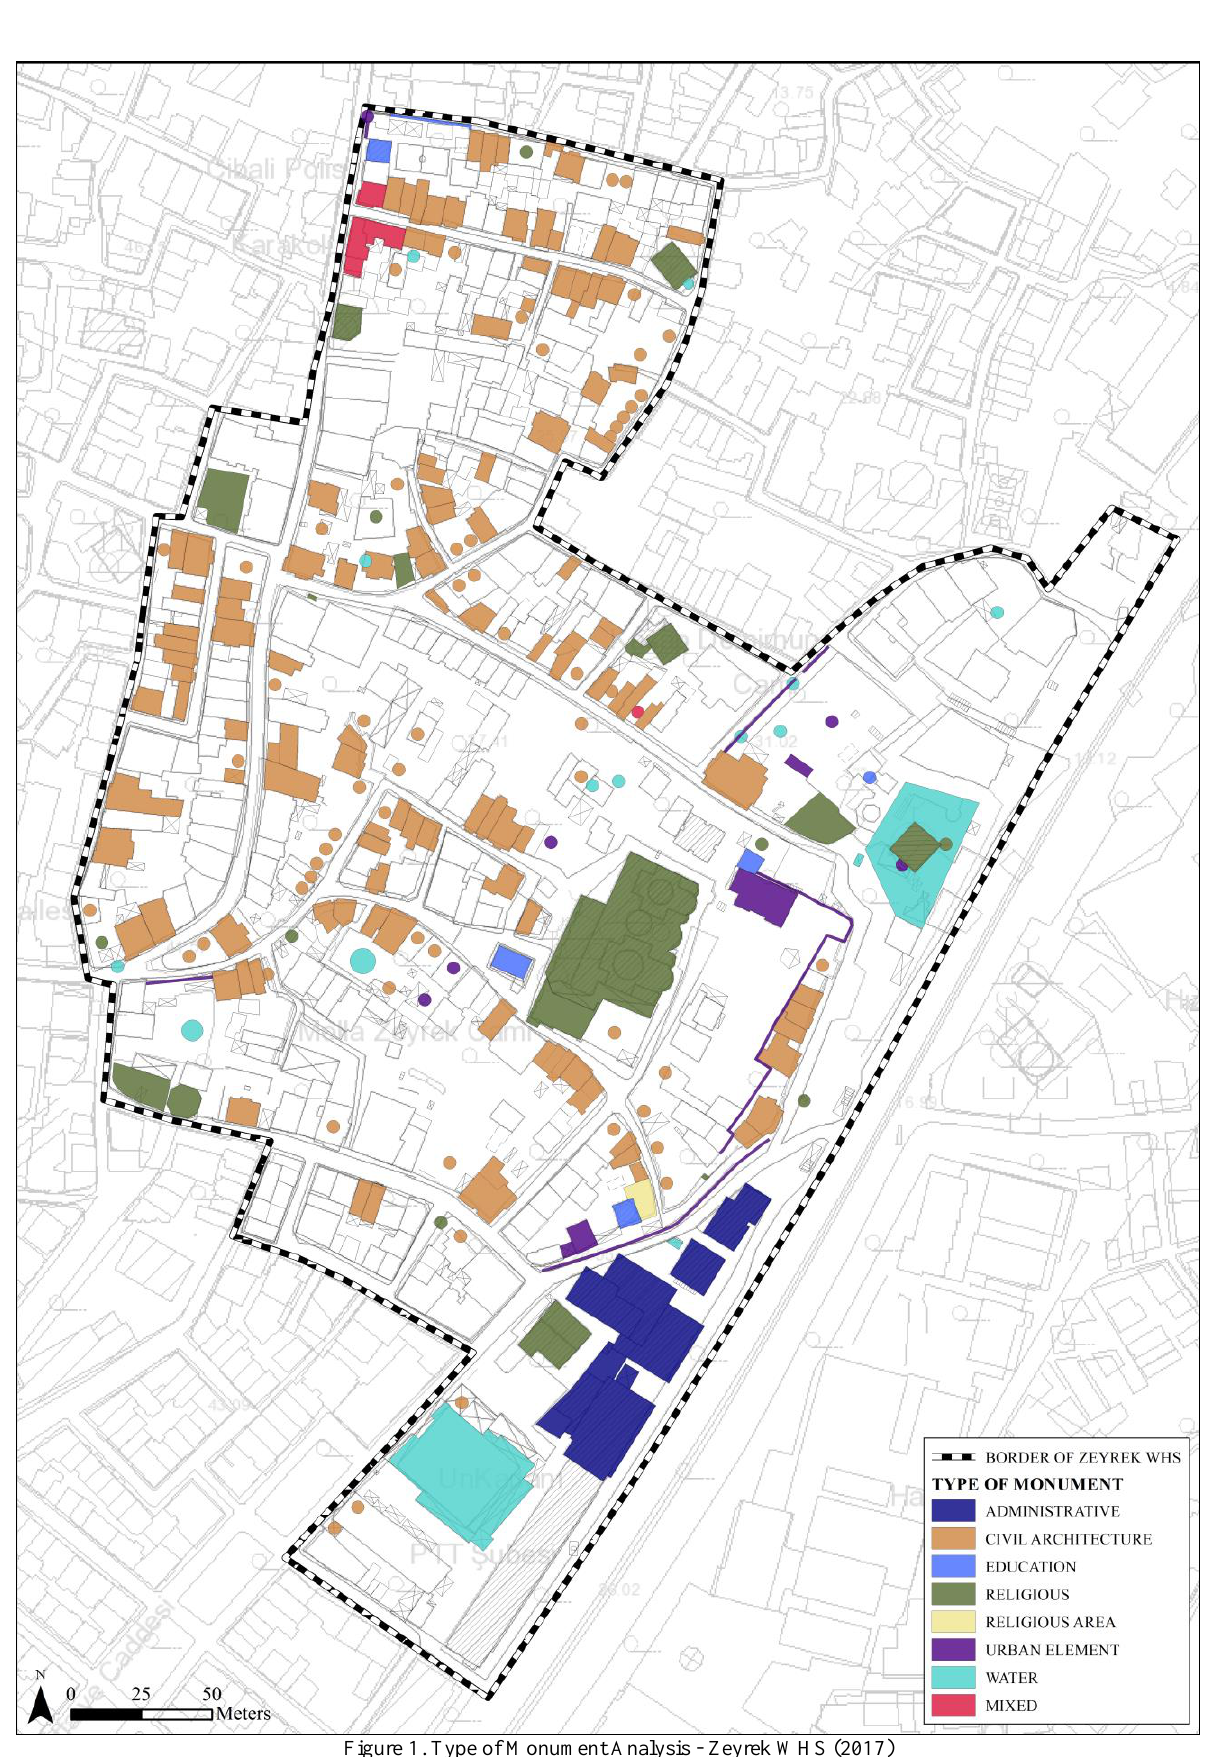
Figure 1. Type of Monument Analysis - Zeyrek WHS